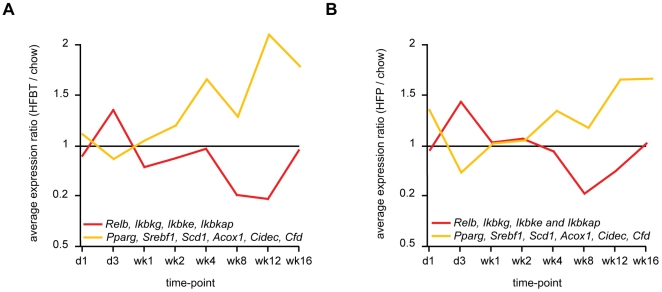
Reciprocal activation of regulators of an inflammatory and steatotic transcriptional programs during high-fat feeding time-course.The average gene expression profiles of NF-kB regulators (RelB, IKBKG, IKBKE, IKBKAP) (red line) and PPARγ/hepatic steatosis-associated genes (PPARγ, SREBF1, SCD1, ACOX1, CIDEC, CFD) (yellow line) during the 16-week high-fat feeding time-course. (A) HFBT vs. chow diet. (B) HFP vs. chow diet.